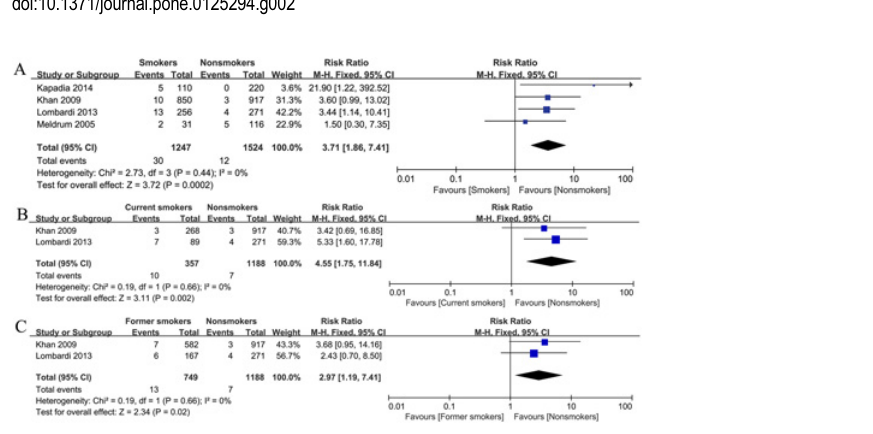
Fig 3. Forest plots of the association between smoking (A), current smoker (B), former smoker (C) and the risk of deep infection after total hip arthroplasty.